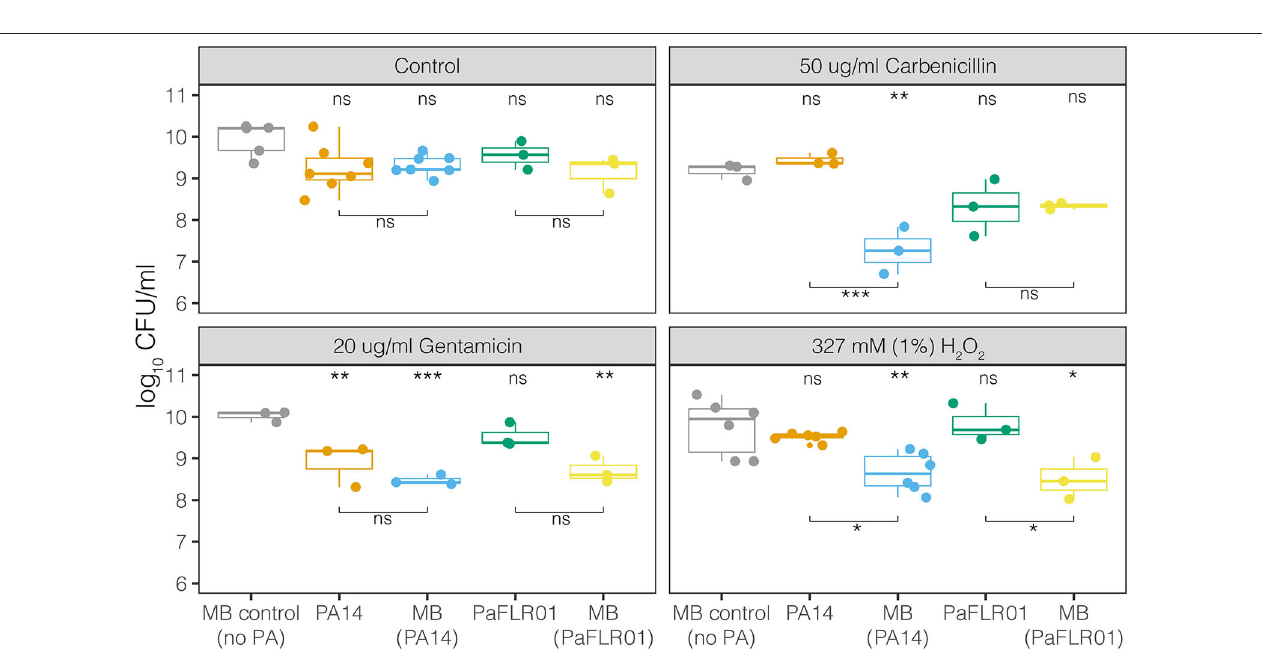
FIGURE 2 | Perfusion and static model growth comparisons for the MB control community across antimicrobial treatments. The MB control community is the microbial background native to the meat. Treatments include control, 327mM (1%) hydrogen peroxide, 50 µ g/ml carbenicillin, and 20 µ g/ml gentamicin. The closed circles represent the perfusion model and the open triangles represent the static model. Each point represents the average from at least three technical replicates from dilution plating for each biological replicate ( N ≥ 3). Statistical testing was performed with ANOVA. Significance is indicated by asterisks. * p < 0.05; ** p < 0.01; **** p < 0.0001.